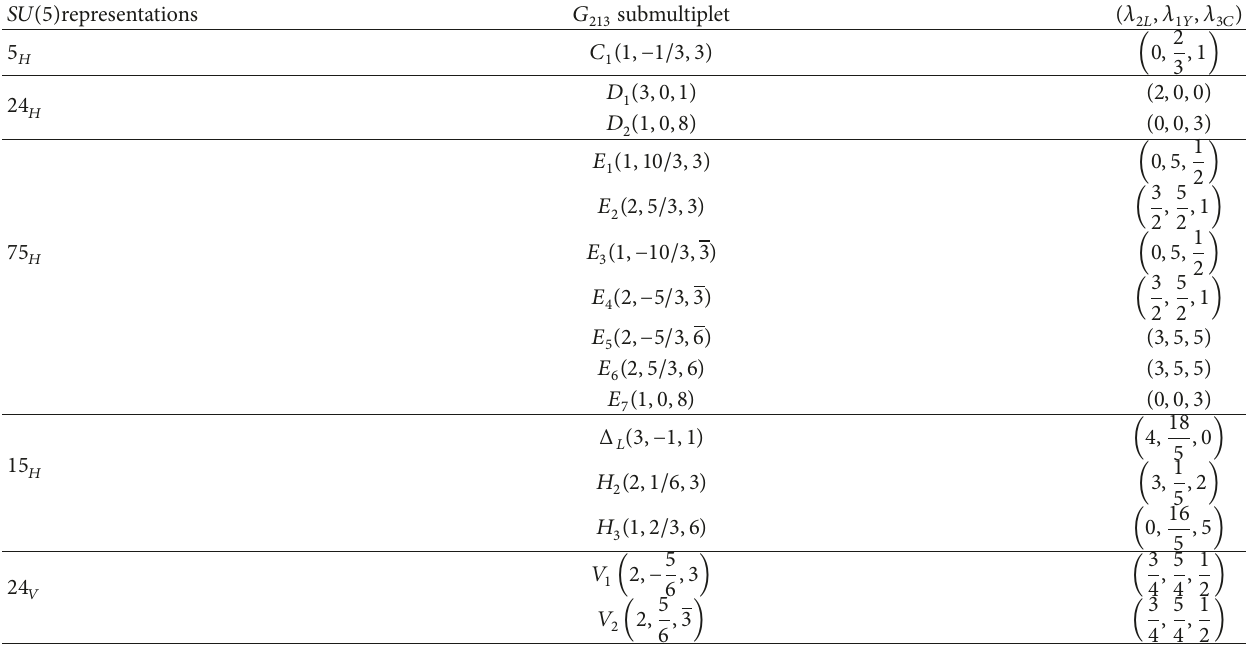
Table 4: Superheavy components of SU(5) representations under the SM gauge group 𝐺 213 used to estimate GUT threshold effects. 𝑆𝑈(5) representations 𝐺 213